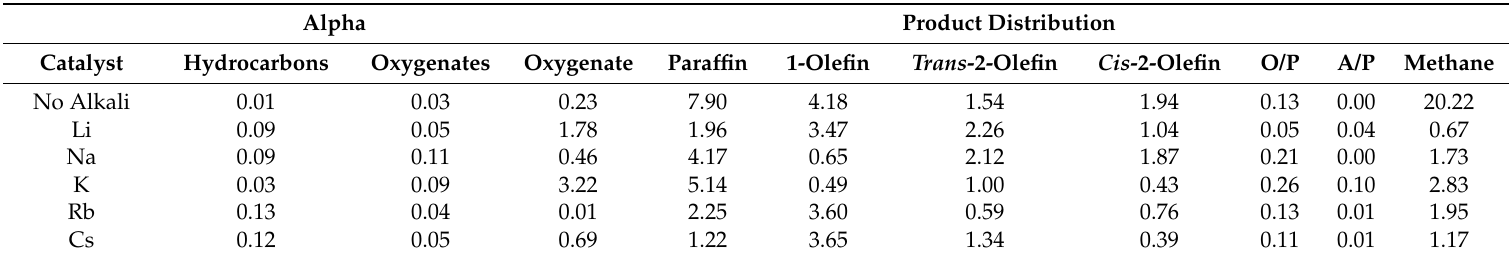
Table 3. Standard Deviations of the Products Based Upon the Change in CO Conversion.